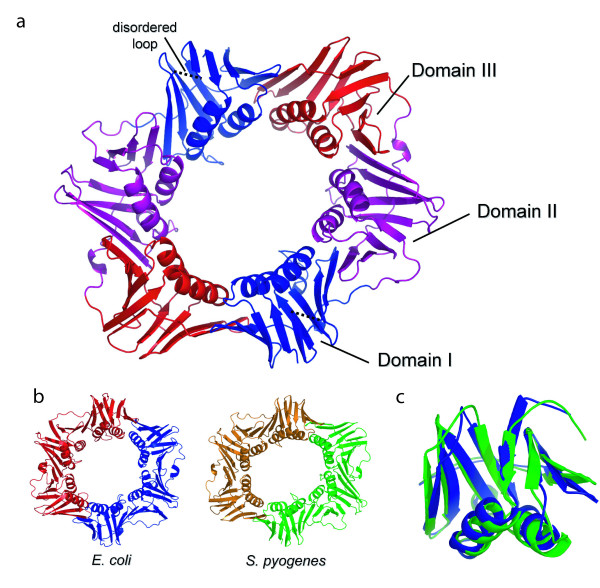
(A) Structure of the Streptococcus pyogenes β subunit. Ribbon representation of the S. pyogenes β subunit. (B) Comparison of S. pyogenes β subunit with E. coli β [10]. (C) Overlay of domain II of S. pyogenes (green) and E. coli (blue) β. Superposition was done with top3d [25], and figures were rendered with PyMol (DeLano Scientific).